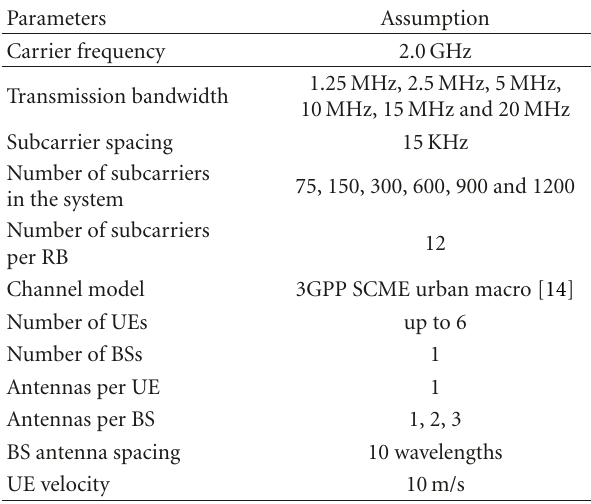
Table 1: Parameter assumptions for